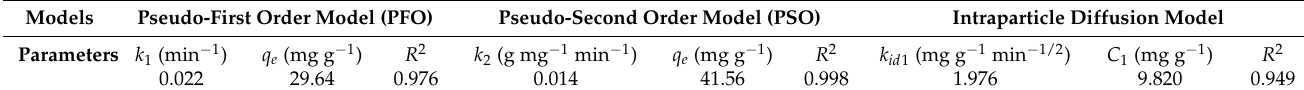
Table 1. Kinetic parameters for the Se(VI) adsorption onto A-LMS Fe 3 O 4.